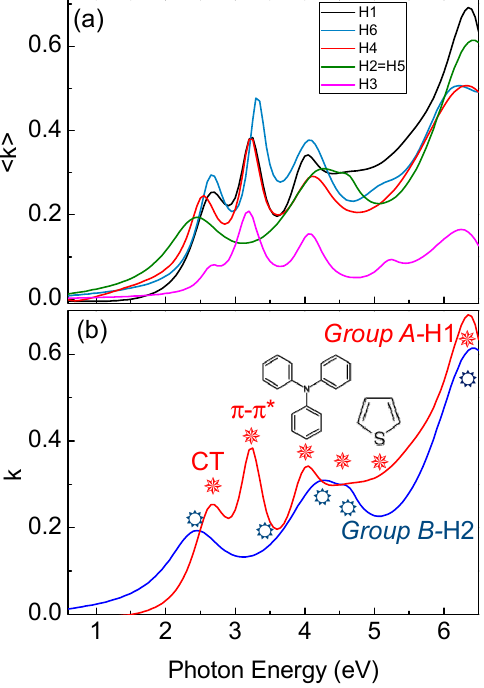
Figure 4. ( a ) Experimental ellipsometric spectra of the pseudoextinction coefficient of all H1 – H6 . ( b ) Spectra of the extinction coefficient of Group A and B . Optical transitions are indicated by symbols.